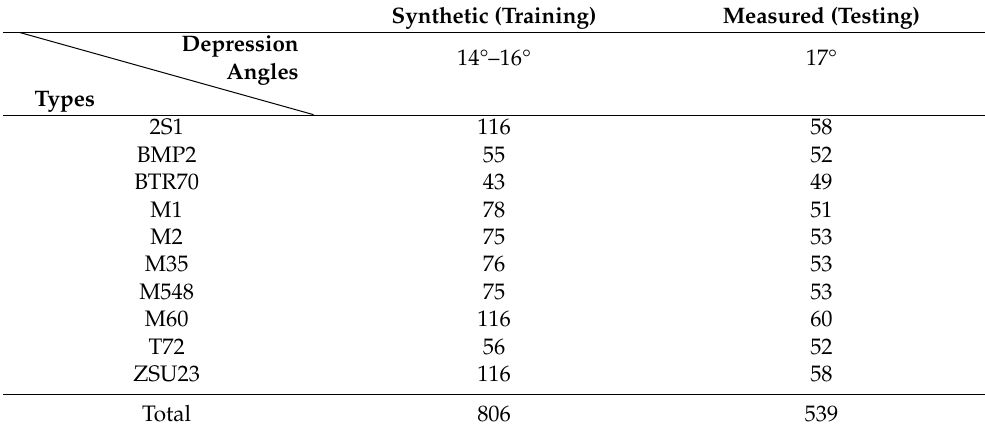
Table 2. Training Scenario II: data types and numbers of samples for training and testing in